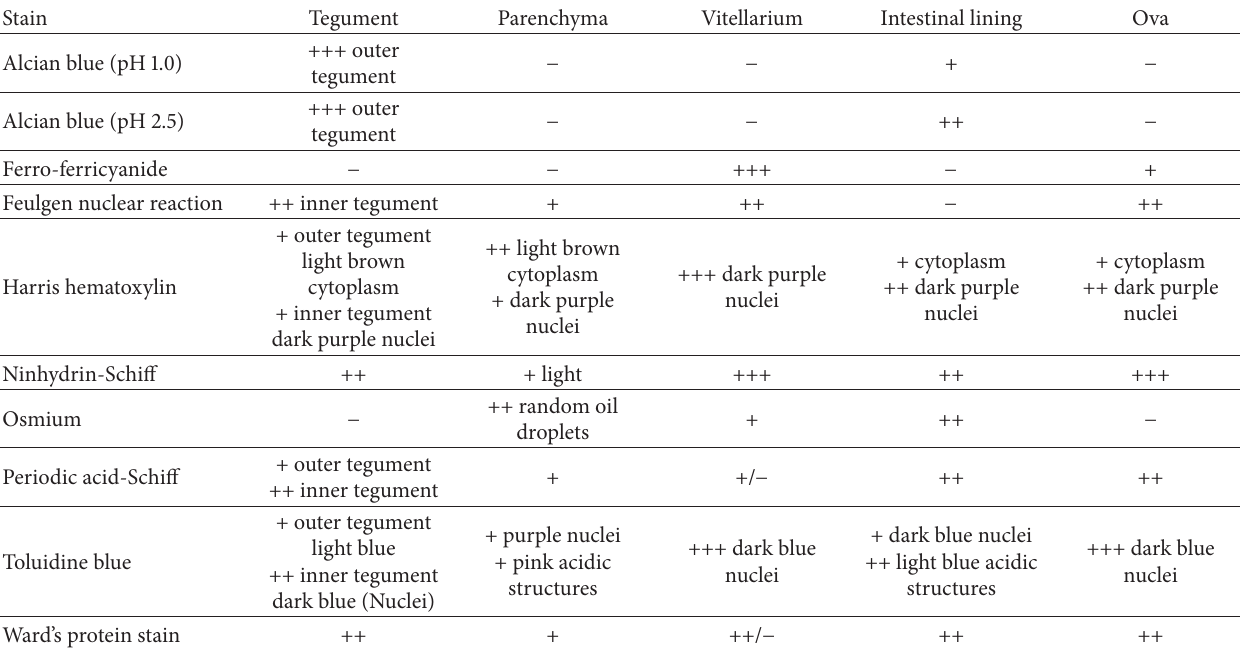
Table 2: Alloglossidium renale adult worm in situ staining